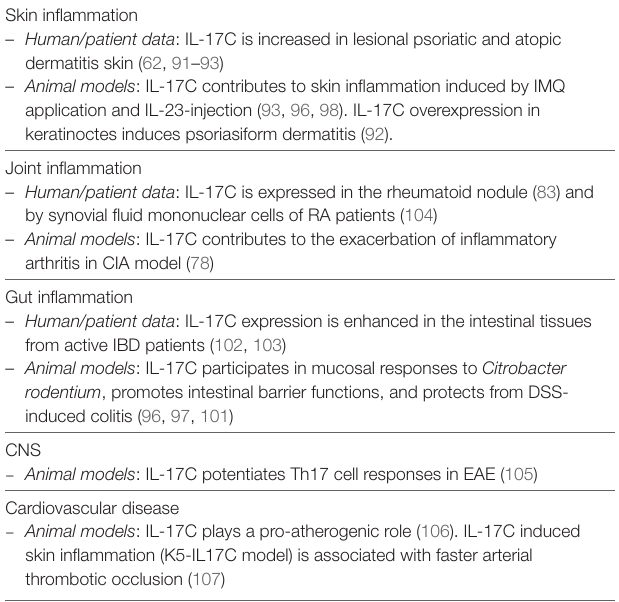
TABLe 5 | Overview of the role exerted by IL-17C in